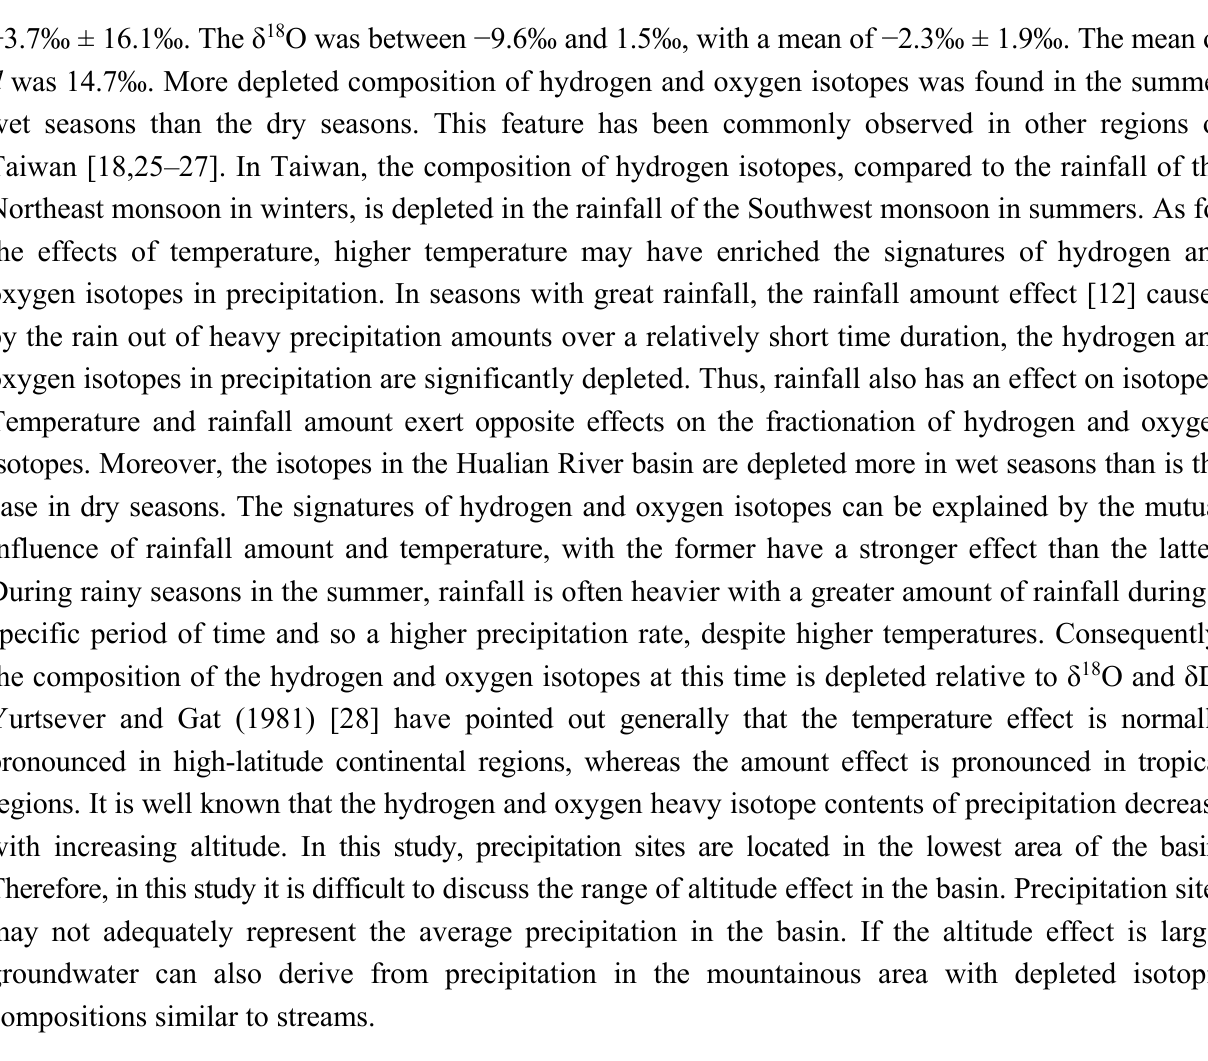
Figure 2. Plot of δ D vs. δ 18 O for precipitation samples. LMWL represents the local meteoric water